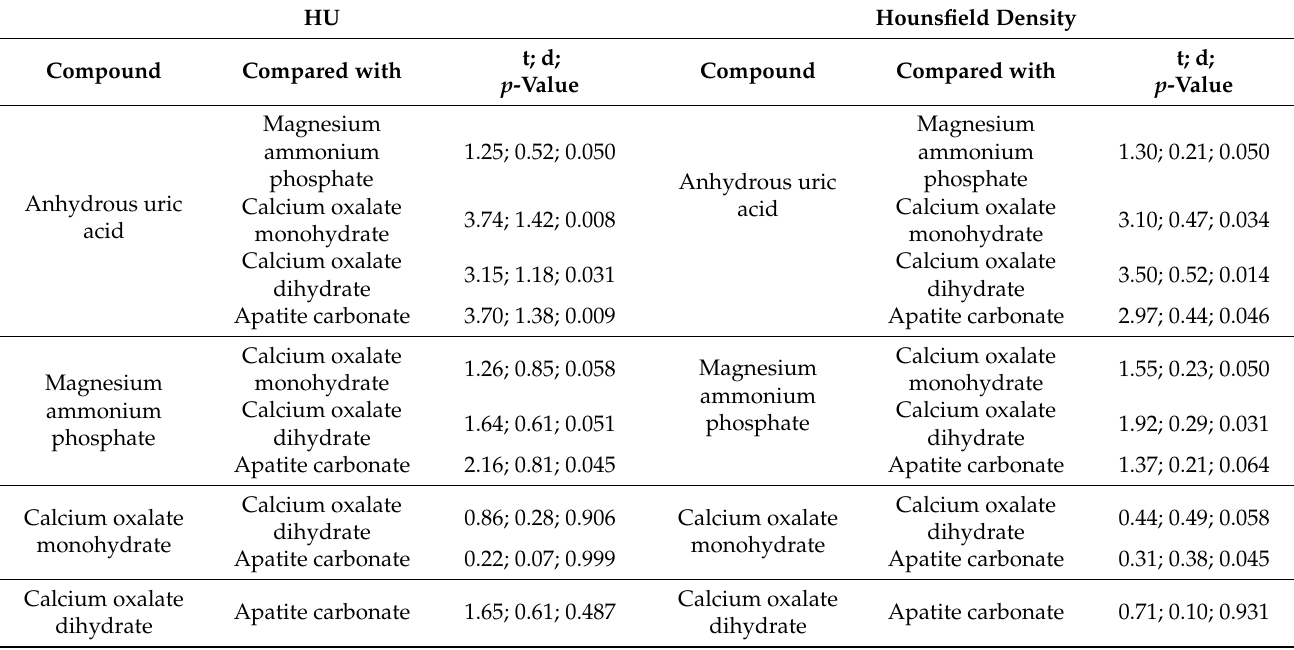
Table 1. Comparison among compounds for HU and Hounsfield